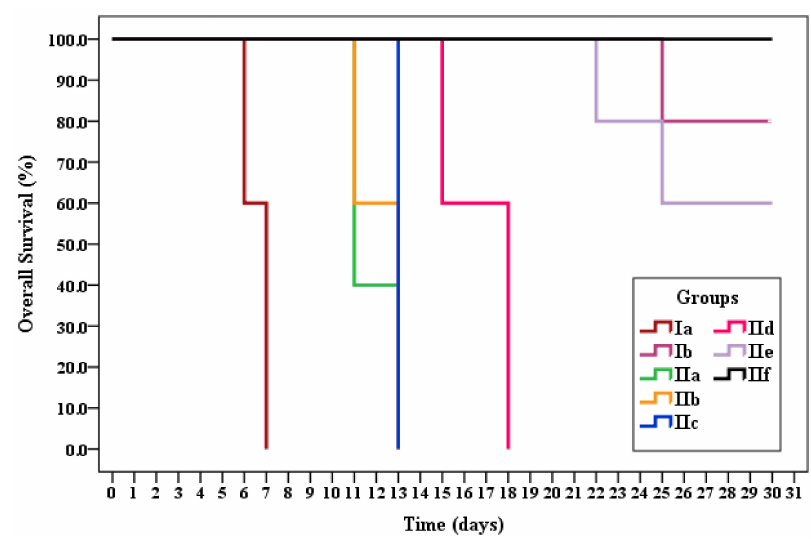
Figure 5. Kaplan-Meier survival curve for all